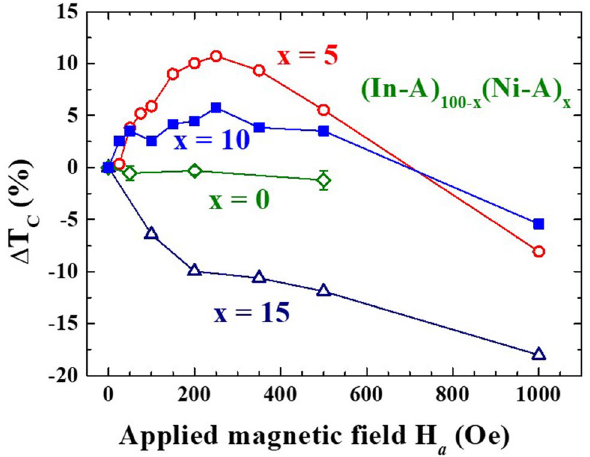
Figure 6. Changes of T C with applied magnetic field of the (In-A) 100−x (Ni-A) x nanoparticle assemblies at x = 0 (open diamonds), x = 5 (open circles), x = 10 (filled squares), and x = 15 (open triangles), revealing the appearance of a critical applied magnetic field for maximum change of T C in the x = 5 and 10